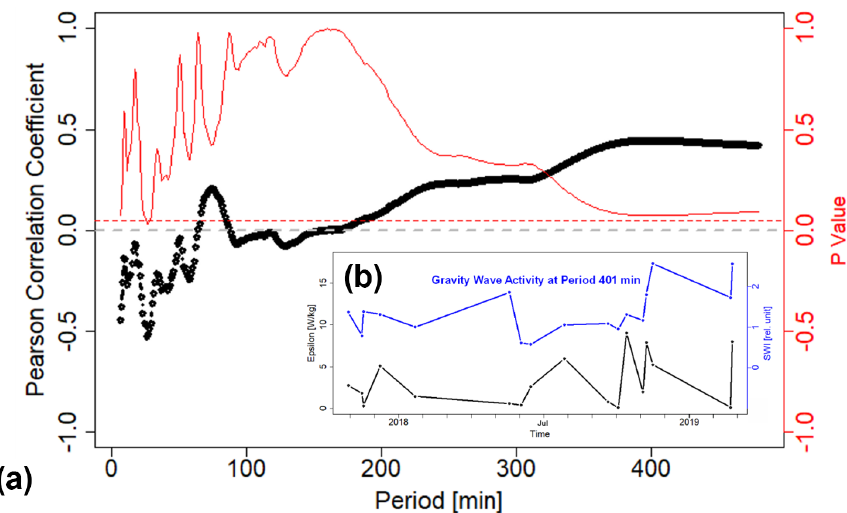
Figure 7. (a) Pearson correlation coefficient (black) between gravity wave activity (SWI) from GRIPS data and energy dissipation rates (cid:15) from FAIM 3 data above OTL. The P value is plotted in red. For all P values of 0.05 (red horizontal line) or less, the correlation coefficient is considered significant. (b) Comparison of (cid:15) and the SWI at period 401min, which is closest to a significant positive correlation in the long-period part of the gravity wave spectrum (Pearson correlation coefficient of